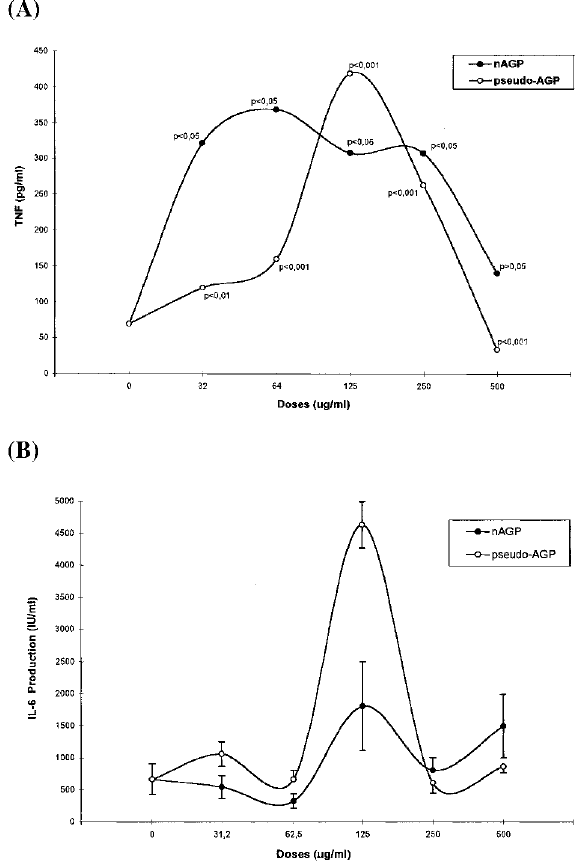
FIG. 3. The effect of natural AGP (nAGP) and pseudo-AGP on in vitro TNF (panel A) and IL-6 (panel B) production by peripheral blood mononuclear cells. The cells were incu- bated for 16–18h with LPS in the presence of different concentrations of nAGP or pseudo-AGP. The supernatants were collected and TNF or IL-6 activity was quantified as described in Materials and Methods. On the panel A P values are presented in comparison with a control.